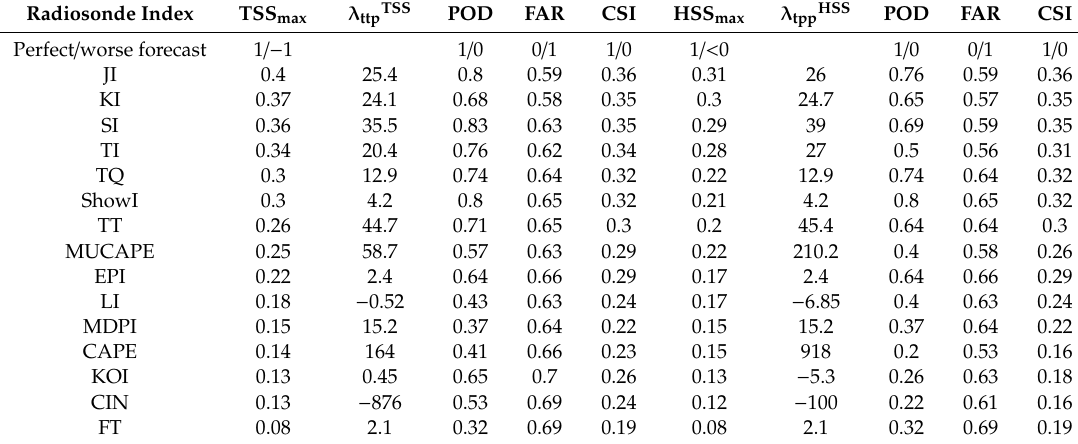
Table 1. The prediction skills of radiosonde indices. The best indices are on the top. TSS, true skill statistics; POD, probability of detection; FAR, false alarm ratio; CSI, critical success index; HSS, Heidke skill score.